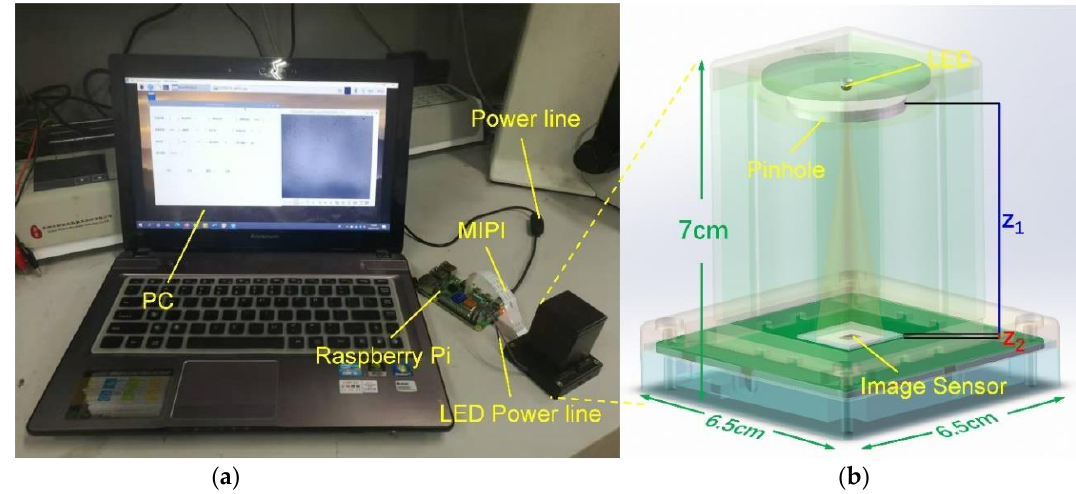
Figure 1. Schematic of the lensless on-chip microscope. ( a ) Photographs of the apparatus, ( b ) structure of in-line holographic imaging device.